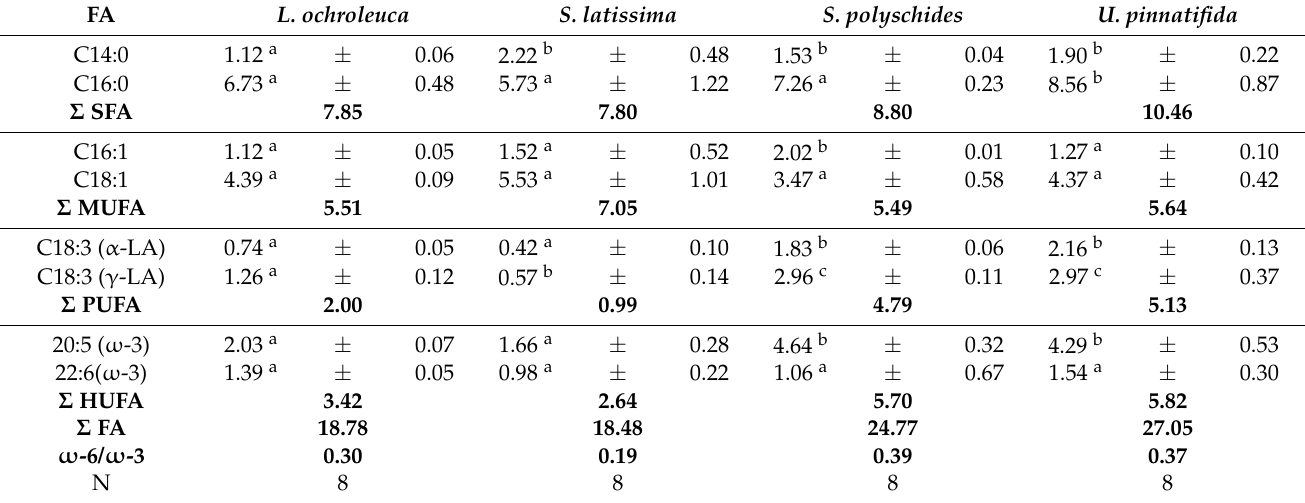
Table 4. Fatty acid (FA) profile and content of each fatty acid (expressed in mg g − 1 ) of the four algae species studied. SFA—saturated fatty acids; MUFA—monounsaturated fatty acids; PUFA—polyunsaturated fatty acids; HUFA—highly unsaturated fatty acids; LA—linolenic acid. N corresponds to the number of different fatty acids found for each species. Results are expressed in mean ± standard deviation ( n = 3). Statistically significant differences in the same fatty acid content among the species are expressed by letters above the bars ( a,b,c,d ). Similar letters indicate no significant differences at the p- value < 0.05 level.